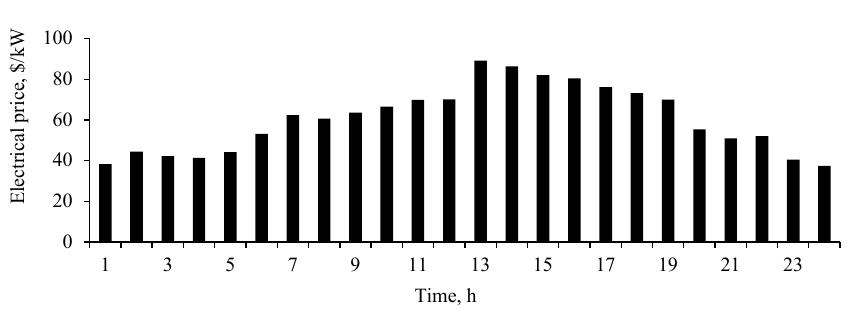
Fig. 2. Electrical price in day-ahead [38], [39].